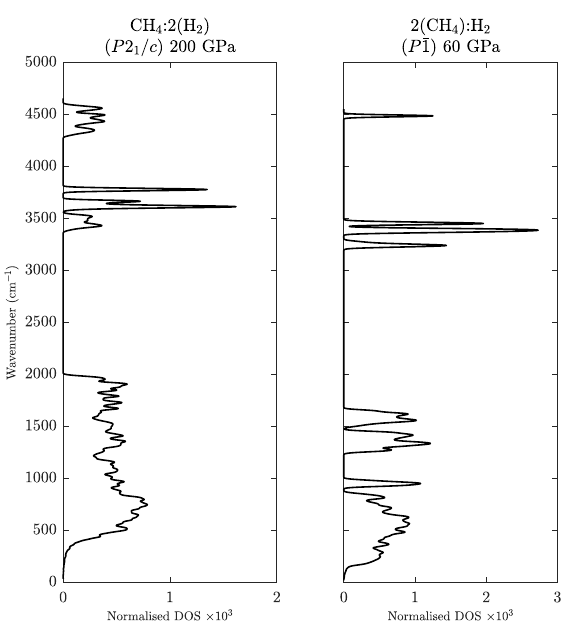
Figure A4. Phonon DOS of CH 4 (H 2 ) 2 at 200 GPa ( left ) and (CH 4 ) 2 H 2 at 60 GPa ( right ).